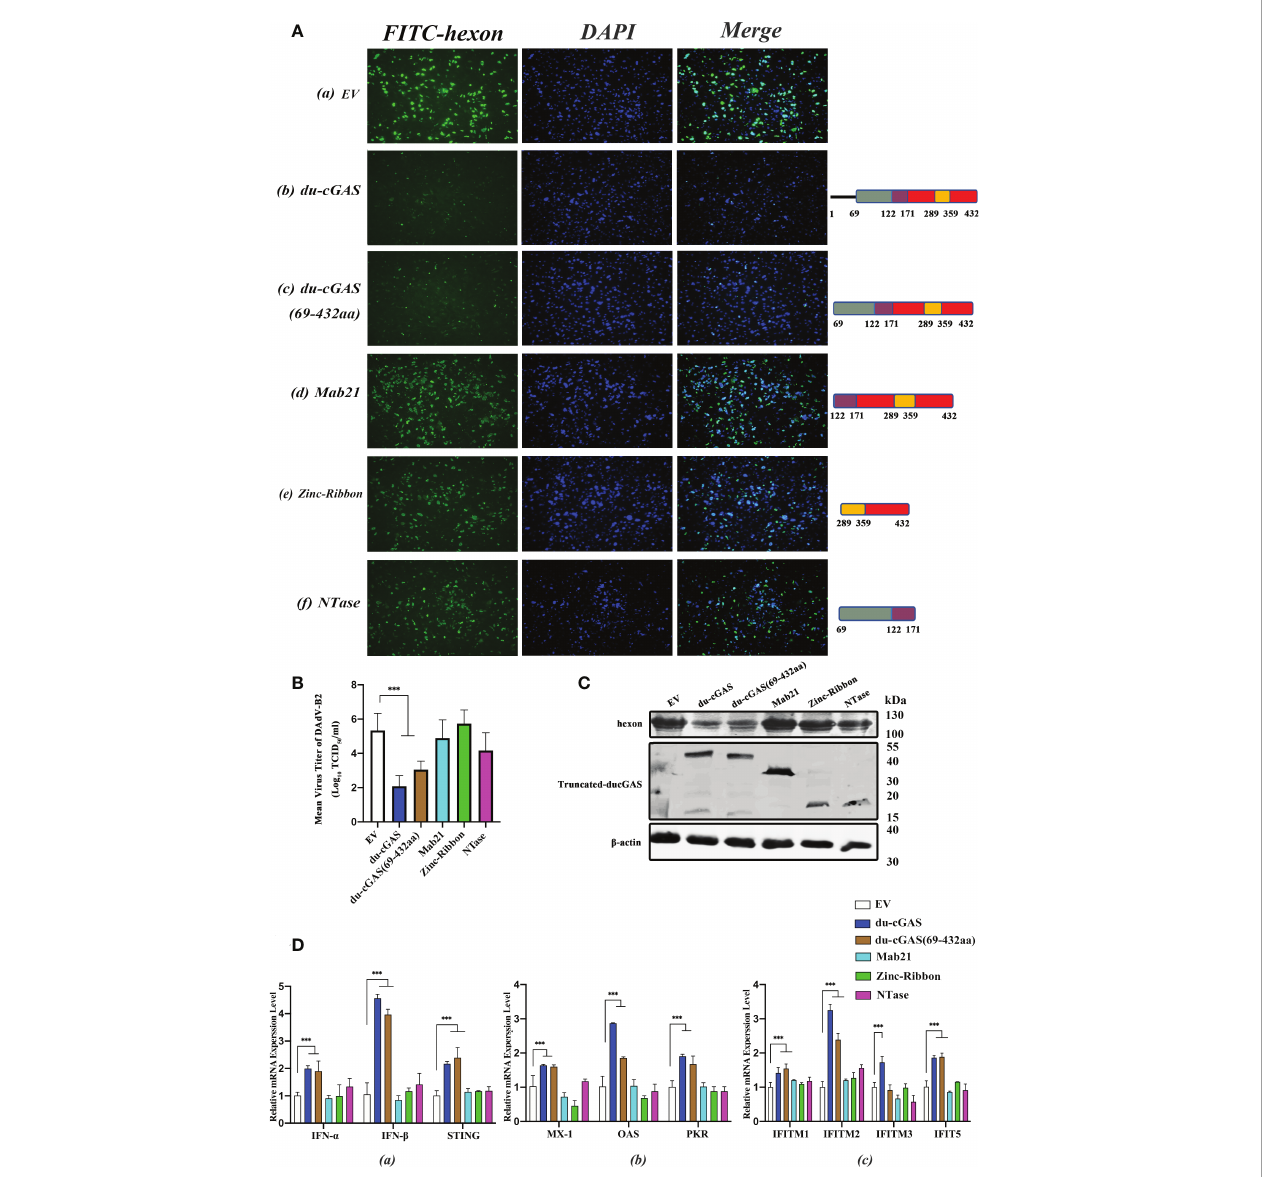
FIGURE 7 Characterization of du-cGAS functional domains. DEFs cells were transfected with expression plasmids encoding full-length du-cGAS, truncated du- cGAS or empty vector (EV). After 24 h post-transfection, cells were infected with DAdV-B2 at the MOI of 1.0 and harvested at 48 hpi. (A) Cell monolayers were detected the expression of DAdV-B2 hexon protein by IFA. (a) empty plasmid; (b) du-cGAS; (c) du-cGAS (69-423aa) (d) Mab21; (e) Zinc-Ribbon; (f) NTase. (B) The viral titers in the cell culture supernatant were detected by TCID 50 assay. (C) The protein expression of full-length and truncated du-cGAS, and DAdV-B2 hexon was detected by western blotting. (D) The relative mRNA expression of type I IFNs, STING and key ISGs was detected by qRT-PCR. Data represent the mean values ± SD, and statistical signi fi cance was analyzed by t-test. * P < 0.05, ** P < 0.01, *** P <